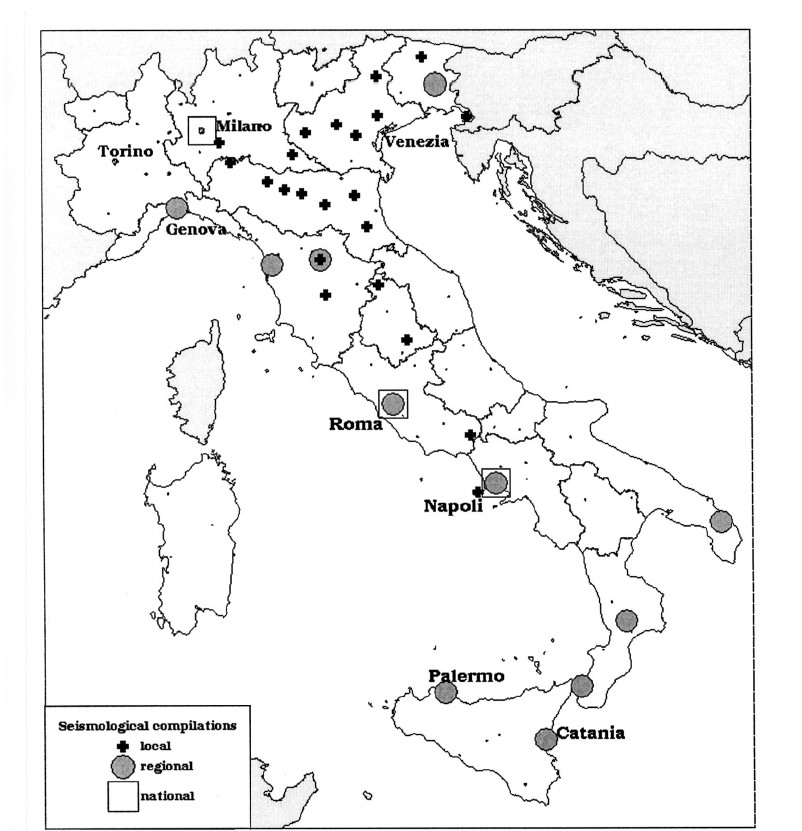
Fig. 1. Geographical distribution of Italian seismological compilation from Bonito (1691) to Baratta